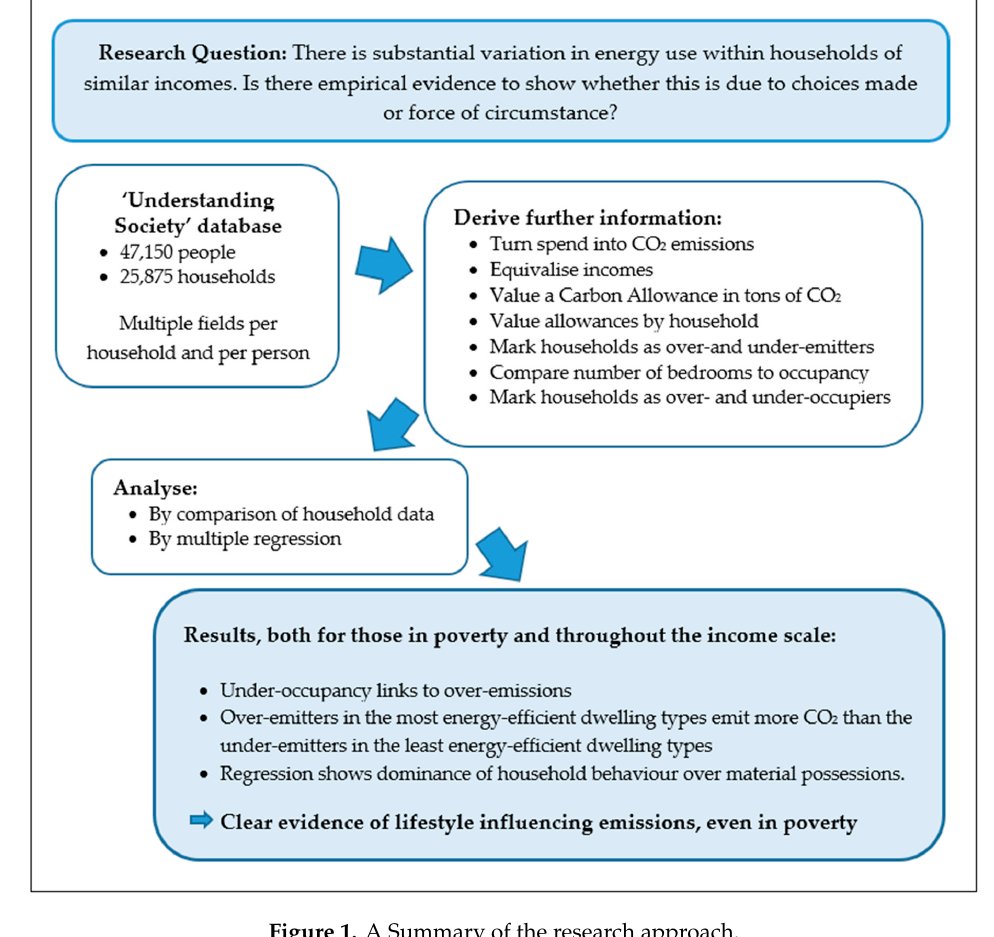
Figure 1. A Summary of the research approach.